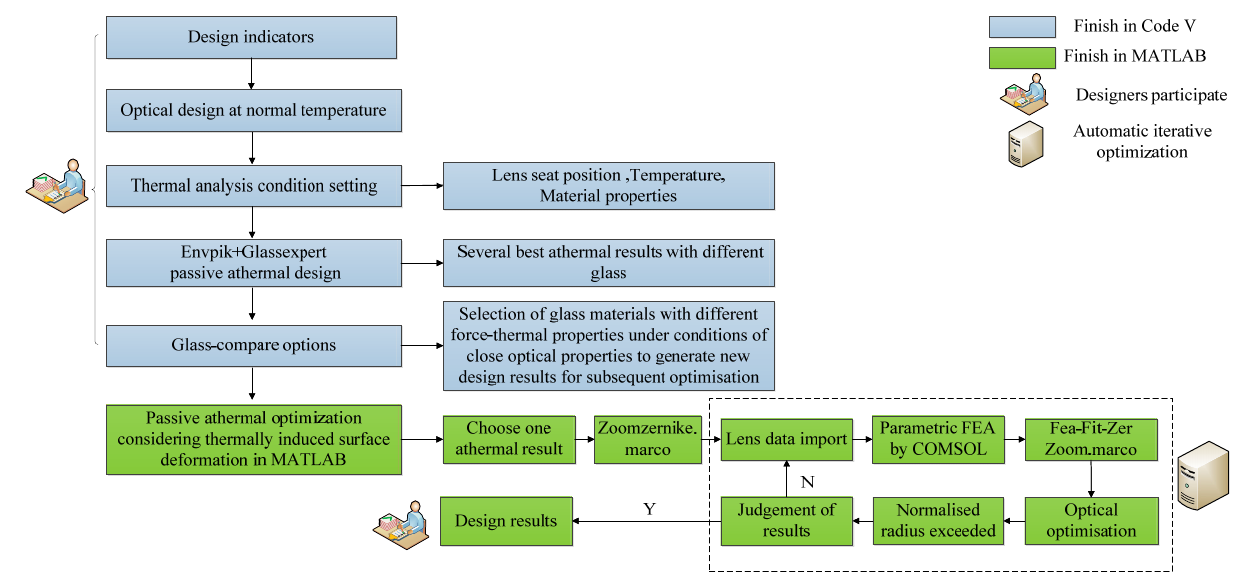
Figure 9. Flow of passive athermal optical design methods considering thermal-induced surface deformation.